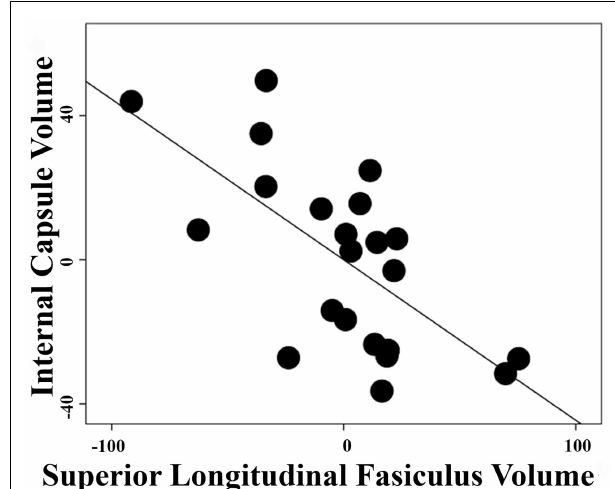
FIGURE 3 | Inter-regional correlation in schizophrenia group . Linear regression was performed with a dependent variable of extracted volumes in the left superior longitudinal fasiculus or left anterior limb of internal capsule/anterior thalamic radiation and covariates of age, gender, and total white-matter volumes. Pearson correlation coefficient between the residuals of extracted volumes from these two regions is r =− 0.66 with p < 0.001 in the schizophrenia